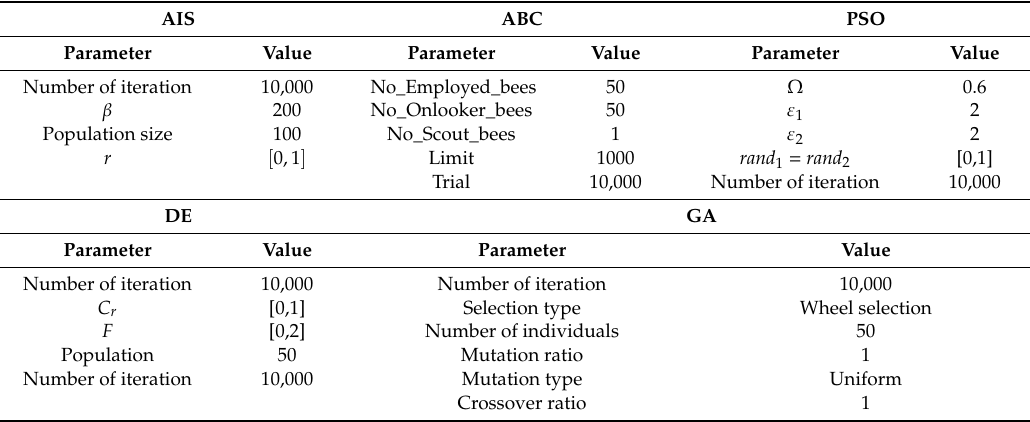
Table 1. Optimal parameters in RBFNN-2SATRA